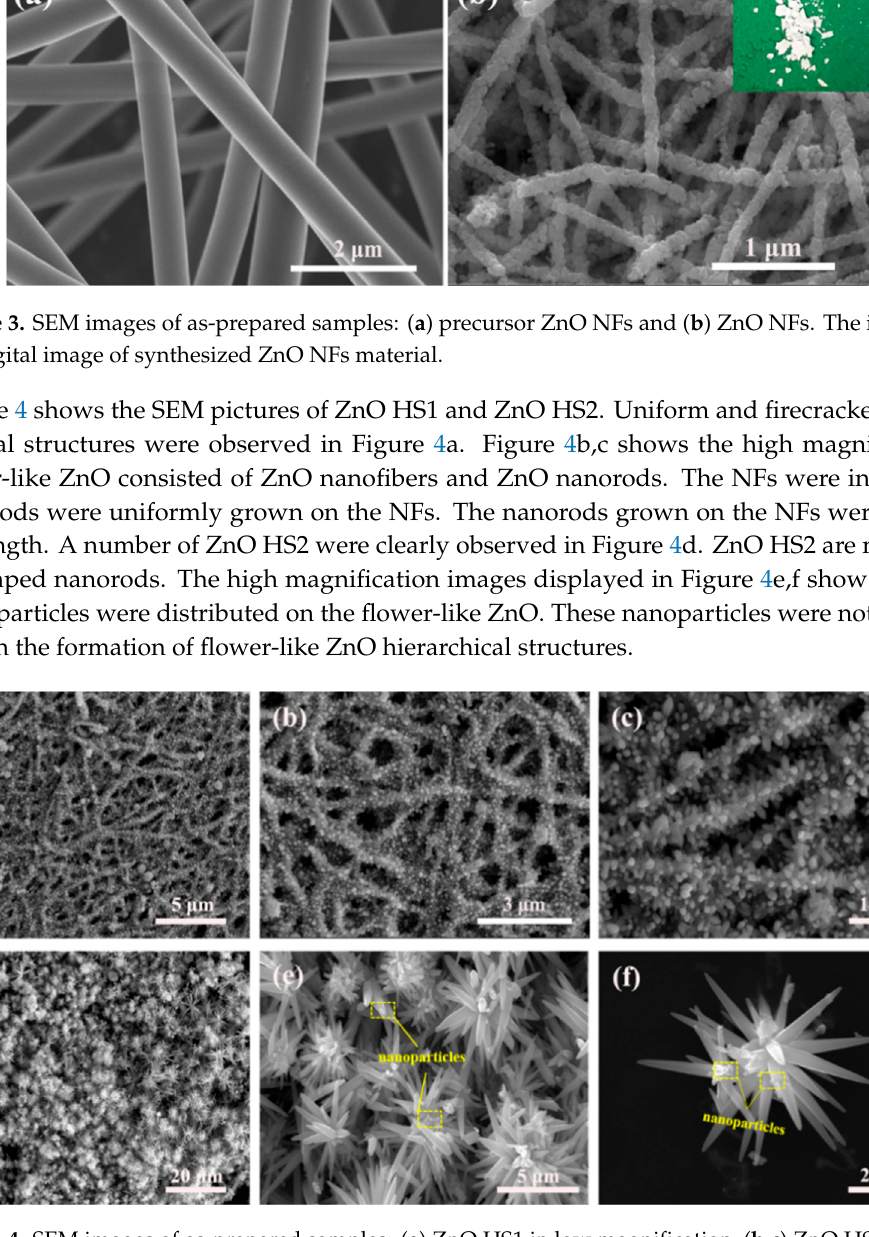
Figure 2. XRD patterns of as-prepared ZnO nanofiber (NF), firecracker-like ZnO (ZnO HS1) and flower-like ZnO (ZnO HS2) materials.